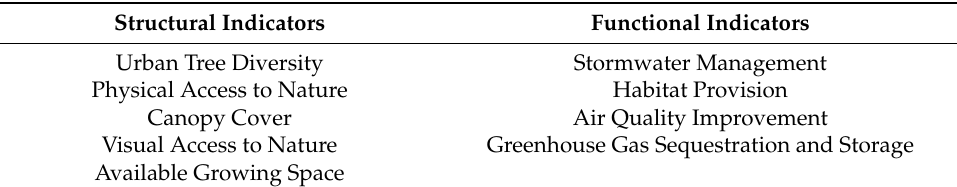
Table 5. Structural versus functional